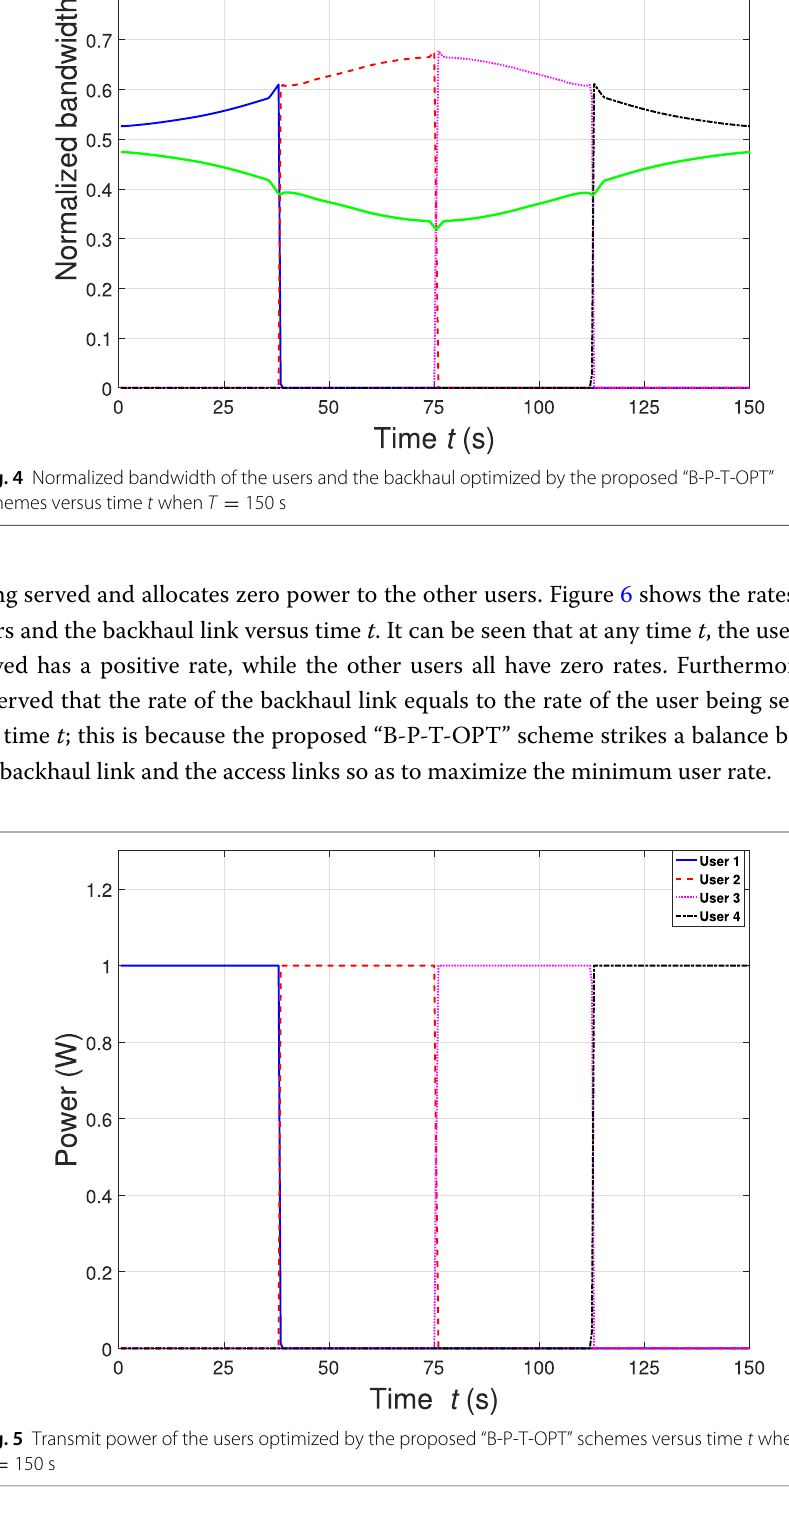
Fig. 5 Transmit power of the users optimized by the proposed “B-P-T-OPT” schemes versus time t when T = 150